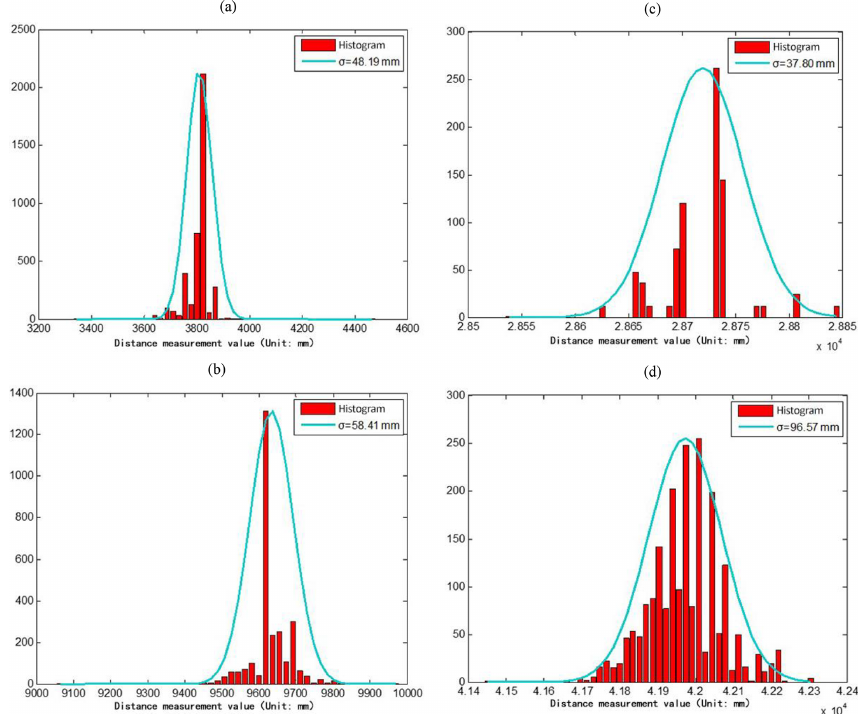
Figure 4. Fitting results of the probability density distribution curve. (a) Probability density at 3560mm. (b) Probability density at 9640mm. (c) Probability density at 28200mm. (d) Probability density at